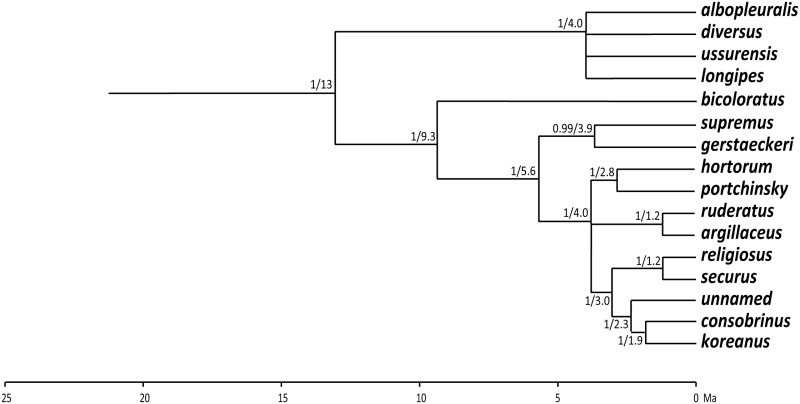
Earlier estimate of phylogeny for species of the subgenus Megabombus.From combined Bayesian analysis of five genes: (mitochondrial) 16S, and (nuclear) opsin, ArgK, EF-1α, and PEPCK [11]. Values at each node: posterior probability / age in Ma. Redrawn with nodes with support p<0.66 shown collapsed. Date estimates in millions of years before the present (Ma) are taken from Hines (her Fig 2) [33]. Species concepts and names are adjusted according to the interpretations of the present study.